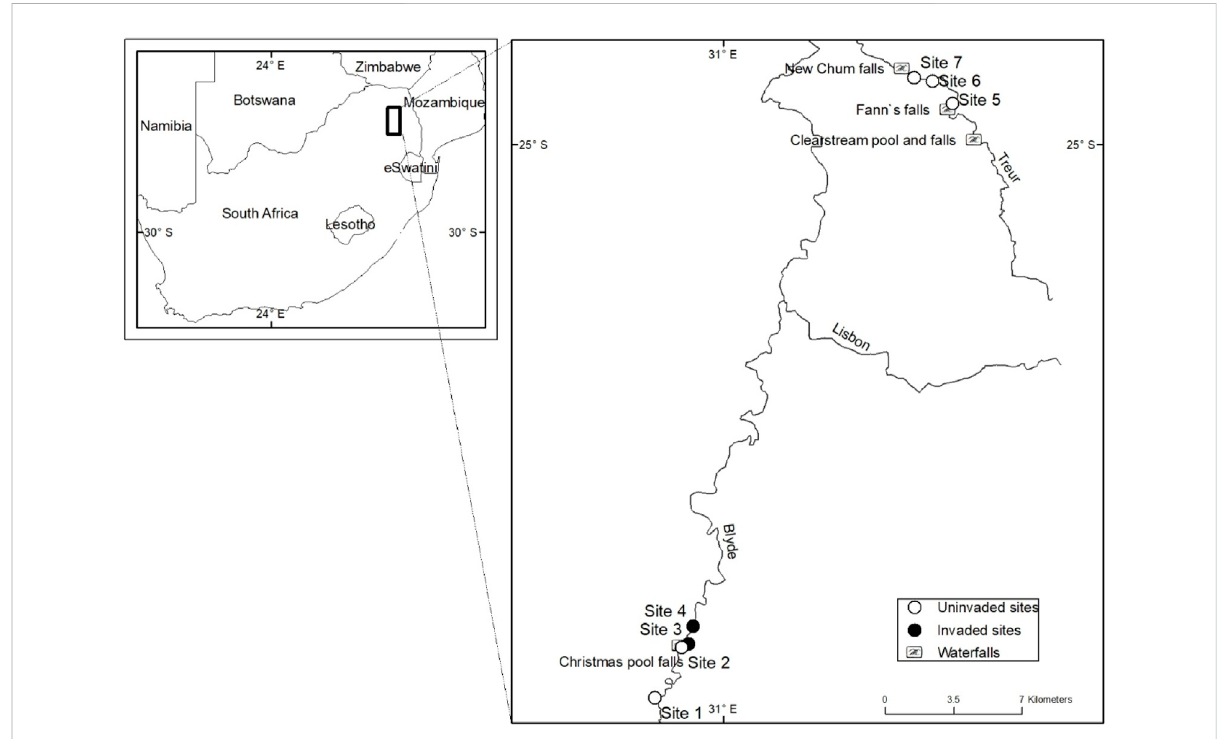
FIGURE 1 Amapshowingthelocationofsitessampled.Sitesinvadedbyrainbowtrout( Oncorhynchusmykiss )( (cid:129) )andsitesfreeofinvasion(o)intheBlyde and Treur rivers in Mpumalanga Province, South Africa.